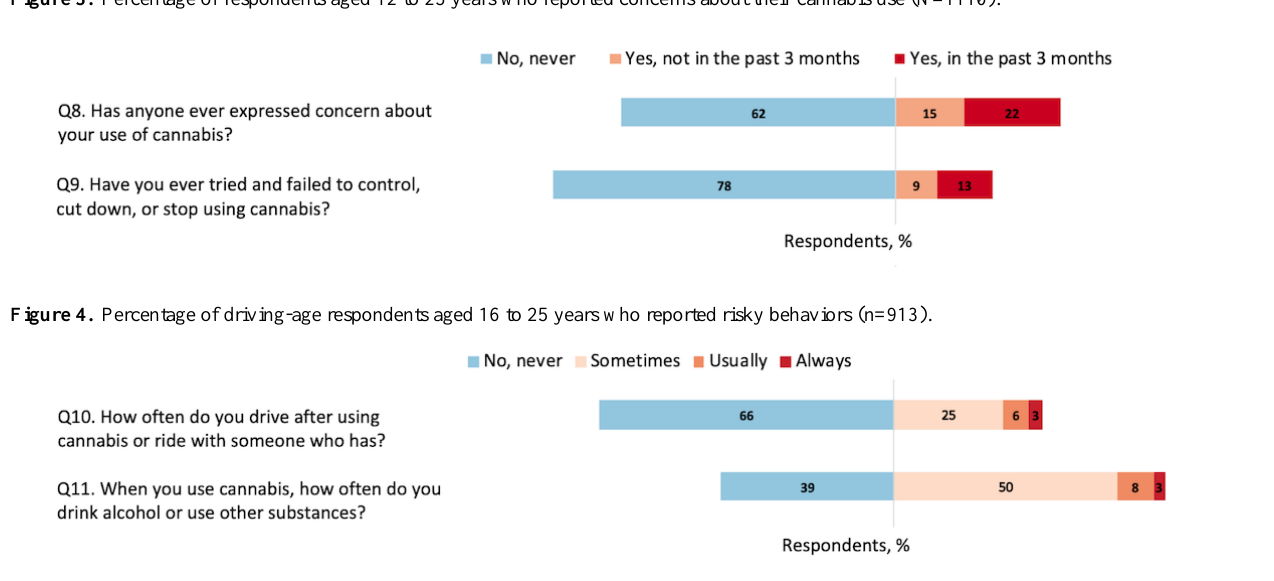
Table 3. Ordered probit estimates for the question “How often do you drive after using cannabis or ride with someone who has?” (n=913).